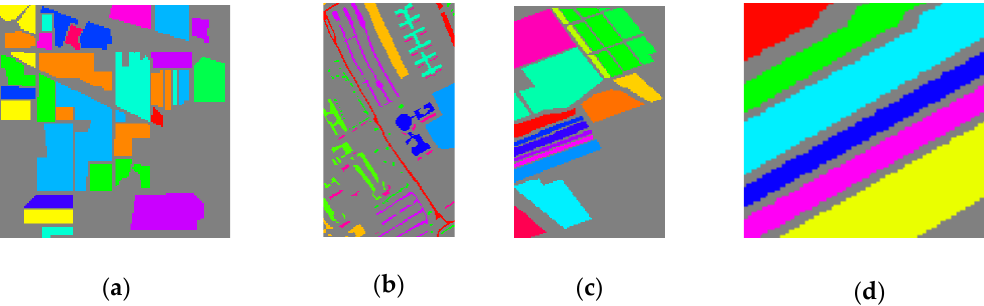
Figure 3. The 80th band of the HSIs. ( a ) Indian Pines; ( b ) Pavia University; ( c ) Salinas; ( d ) SalinasA.